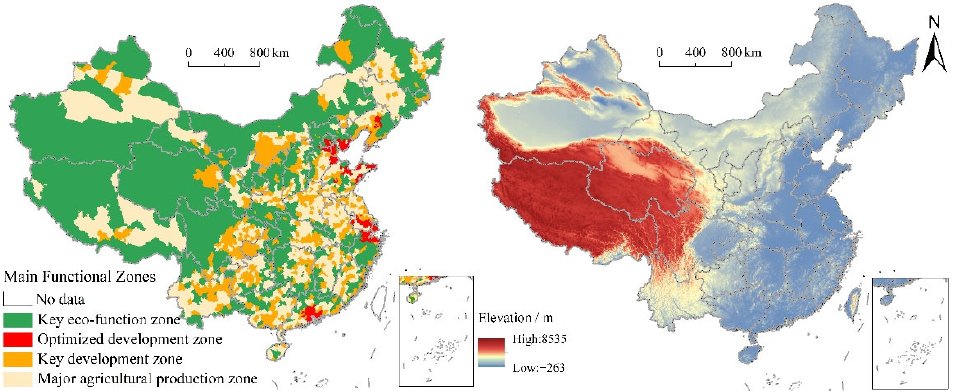
Figure 1. Spatial distribution of MFZ and elevation in